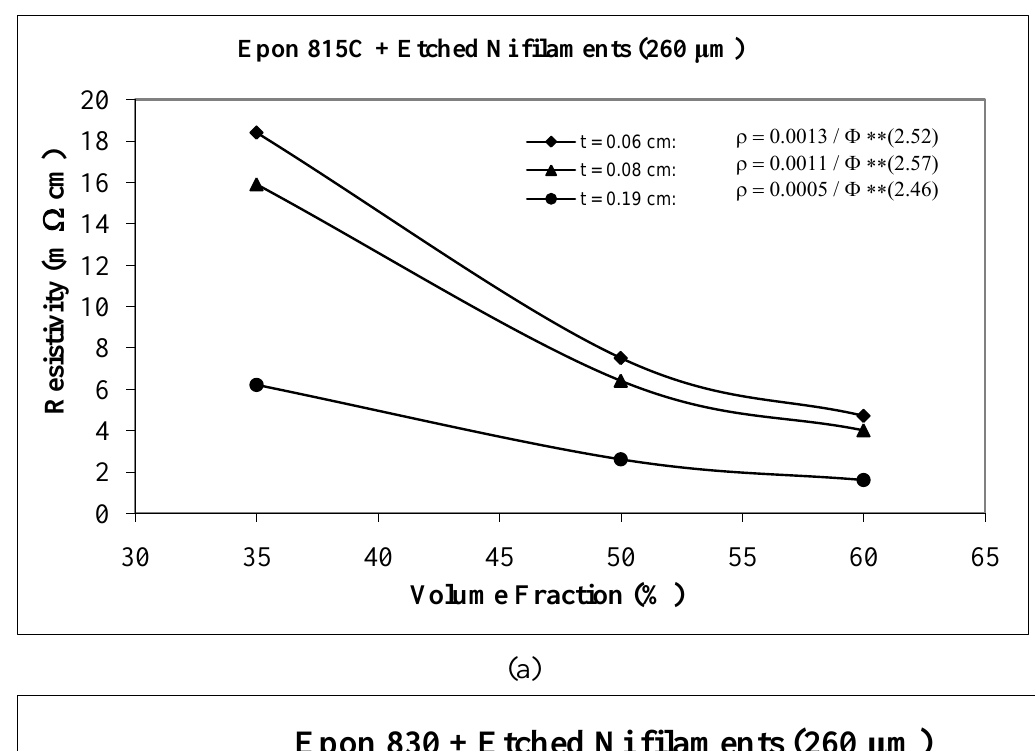
Figure 21. Volume fraction-thickness dependent resistivity of Epon 815C ( a ), and 830 ( b ) films filled with etched nickel filaments (260 